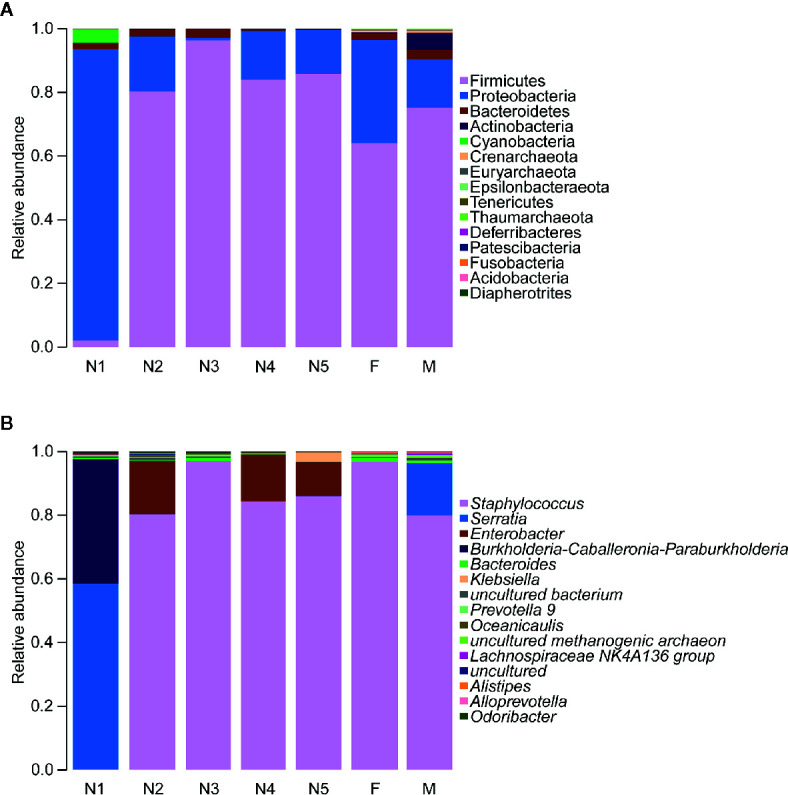
Relative abundances of the 15 most important gut microbiota constituents at the phylum level (A) and genus level (B) across development stages of T. rubrofasciata, as assessed by 16S rRNA sequencing. Each column represents the composition of the microbial taxa in one group (N1, 1st stage nymphs; N2, 2nd stage nymphs; N3, 3rd stage nymphs; N4, 4th stage nymphs; N5, 5th stage nymphs; F, female adult; M, male adult).